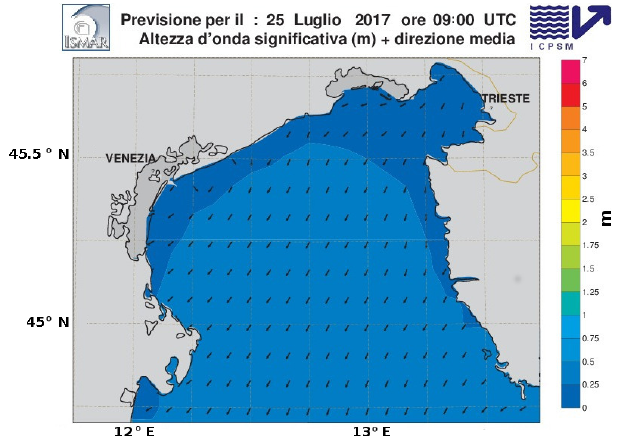
Figure 7. Wave field (very mild conditions) in the northern Adriatic Sea at 09:00UTC on 25 July 2017. The arrows show the signifi- cant wave height and mean direction. The modelled maximum wave height in the field is close to 0.5m. Wind and waves were from the